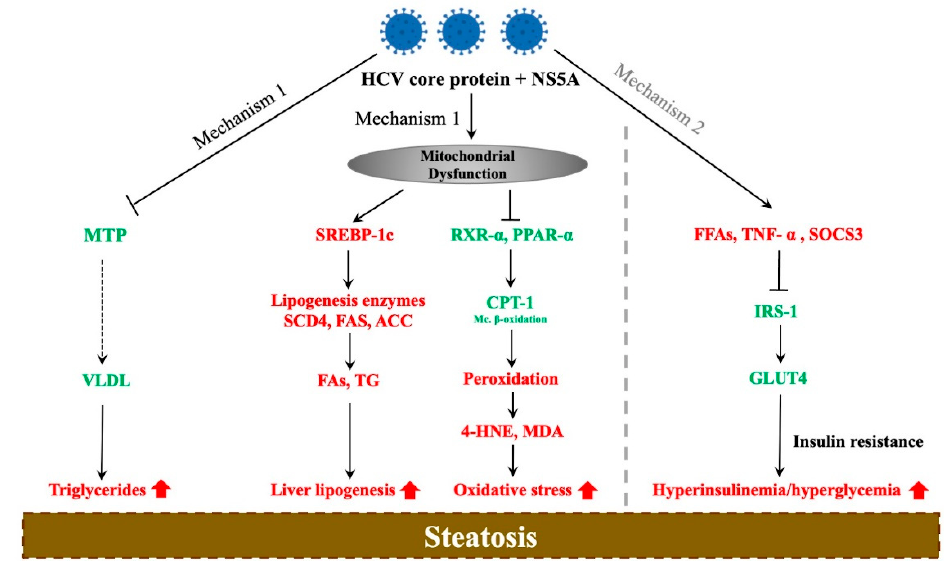
Figure 1. The effect of hepatitis C virus on liver steatosis development. Red and green illustrate upregulation and down- regulation, respectively. HCV: hepatitis C virus; MTP: microsomal triglyceride transfer protein; VLDL: very-low-density lipoprotein; SREBP- 1c: sterol regulatory element-binding-protein 1c; SCD4: sterol CoA dehydrogenase 4; FAS: fatty-acid synthase; ACC: acetyl-CoA carboxylase; PPAR- α : peroxisome proliferator-activated receptor alpha; CPT-1: carnitine pal- mitoyltransferase-1; 4-HNE: 4-hydroxynonenal; MDA: malondialdehyde; FFAs: free fatty acids; TNF- α : tumor necrosis factor alpha; SOCS3: suppressor of cytokine signaling 3; IRS-1: insulin receptor substrate signaling; Mc. β -oxidation: mi- tochondrial β -oxidation; GLUT-4: glucose transporter type 4.